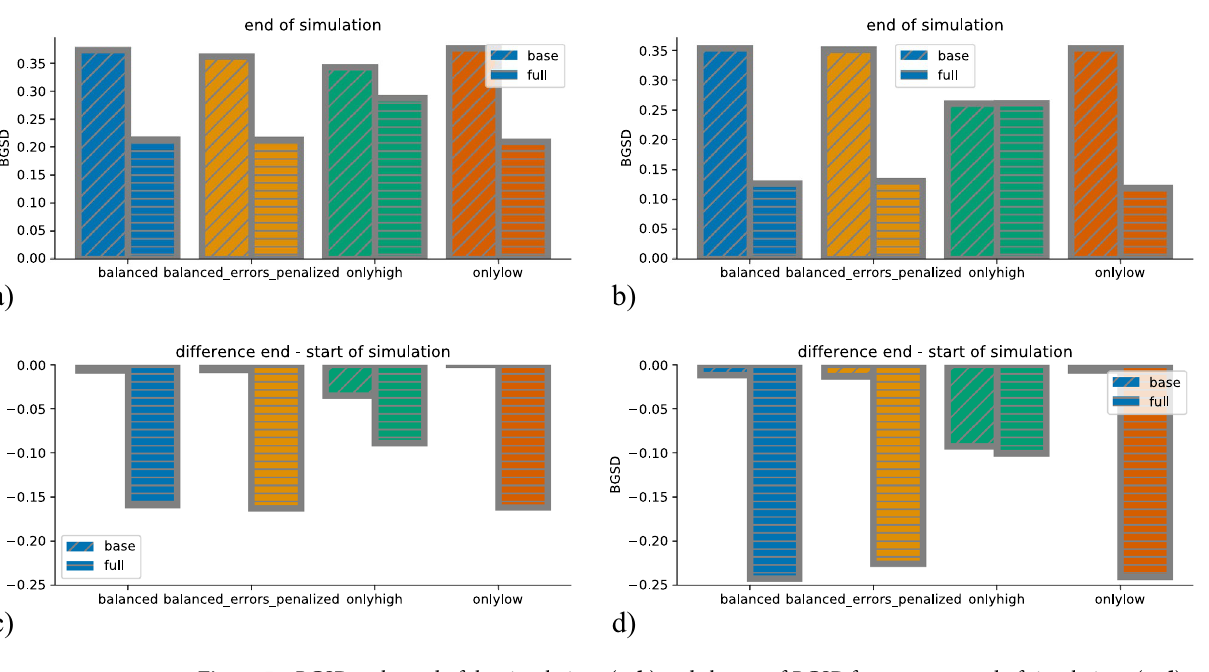
Figure 5. BGSD at the end of the simulations ( a , b ) and change of BGSD from start to end of simulations ( c , d ), for all intervention scenarios. a and c show the simulations for the unbiased, ( b and d ) the simulations for the biased labor market. Different colors indicate different intervention scenarios, and different hatching indicates the base (without protected attribute) and the full model (protected